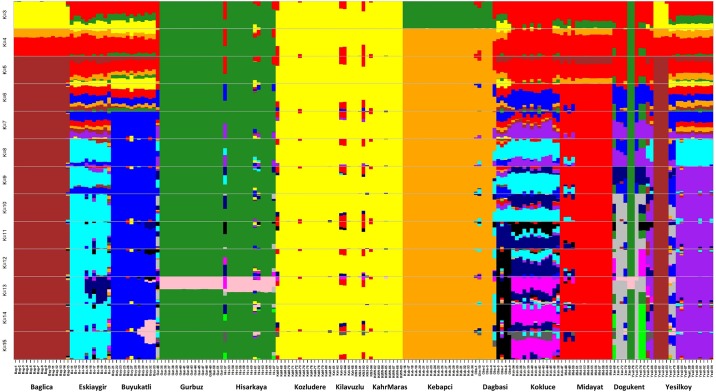
Assignment of 187 individuals to genetic clusters identified by STRUCTURE analysis, for K = 3 to 15, using 18,397 SNP.